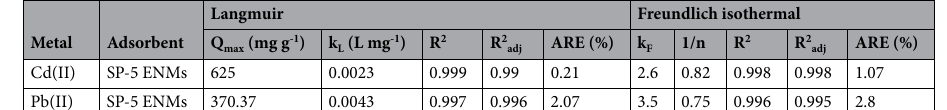
Metal Adsorbent